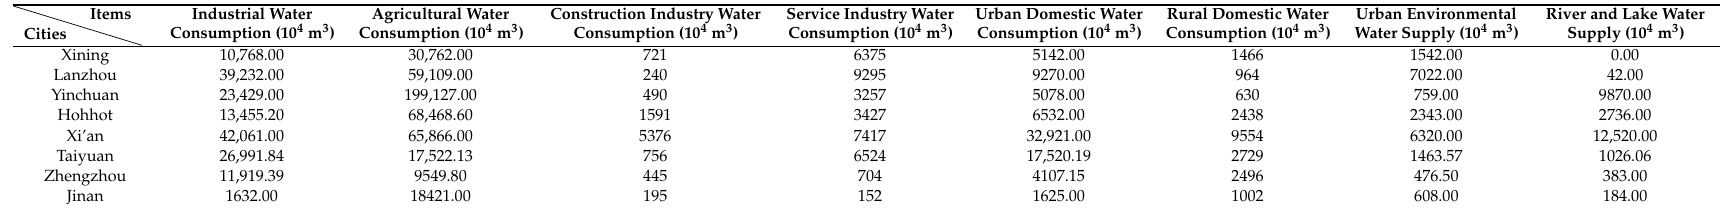
Table 1. Water consumption of water users in typical cities of the Yellow River Basin in 2015.